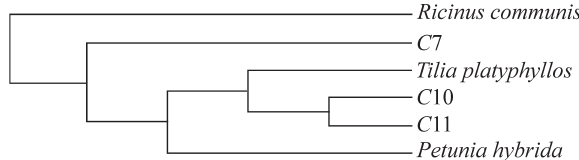
Figure 2 - Cladogram showing phylogeny relation among contigs 7, 10 and 11 with nitrate reductase from Petunia hybrida (gi|294113), Tilia platyphyllos (gi|24474445) and Ricinus communis (gi|11119240). Figure 3 - Cladogram showing phylogeny relation among contigs 4, 5, 6